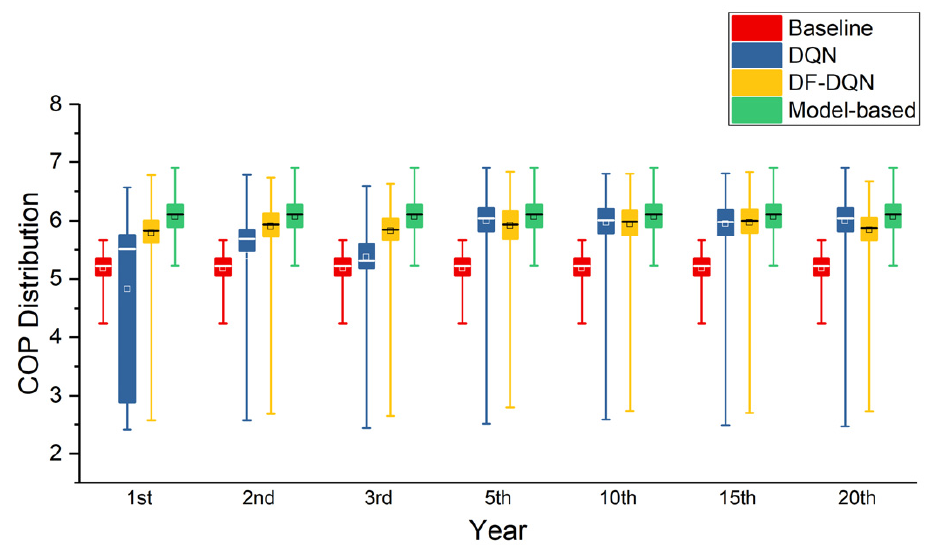
Figure 14. COP comparison of each method.